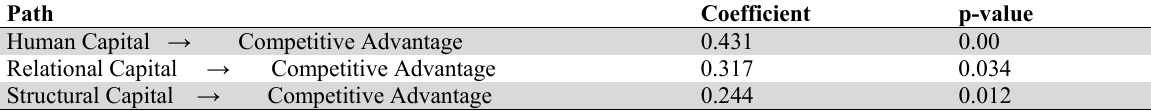
Regression Results for Intellectual